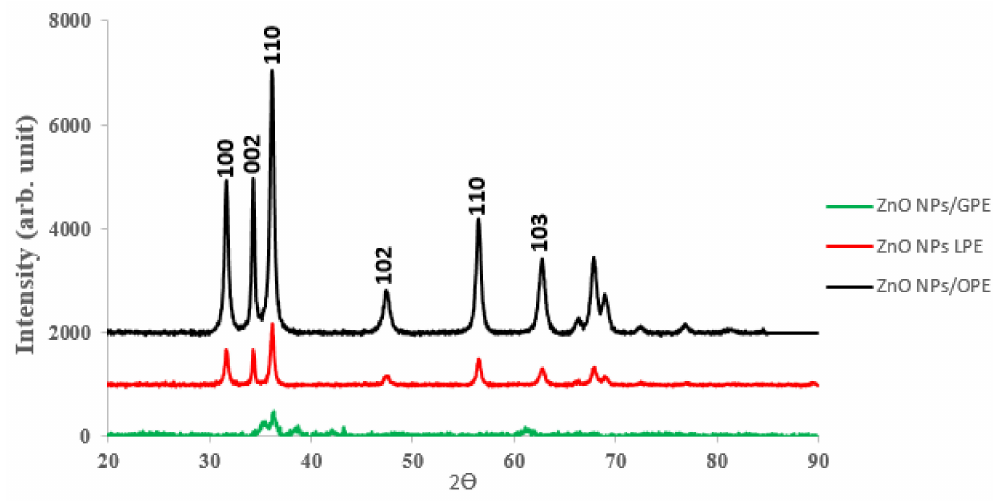
Figure 9. The XRD patterns of the ZnO NPs the three citrus peel extract.